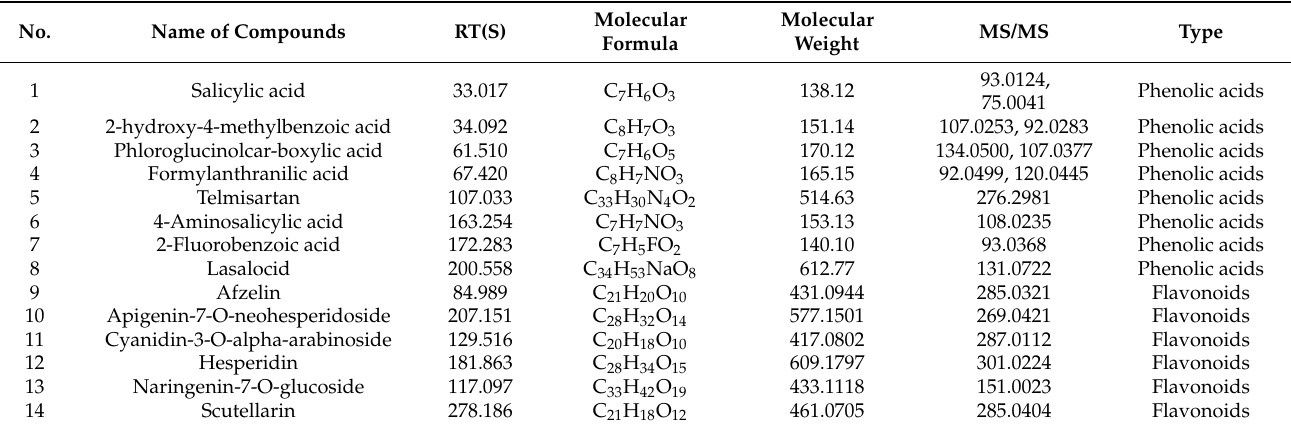
Table 3. Identification of phenolic acids and flavonoids in the EAF fraction of crude extract from quinoa by